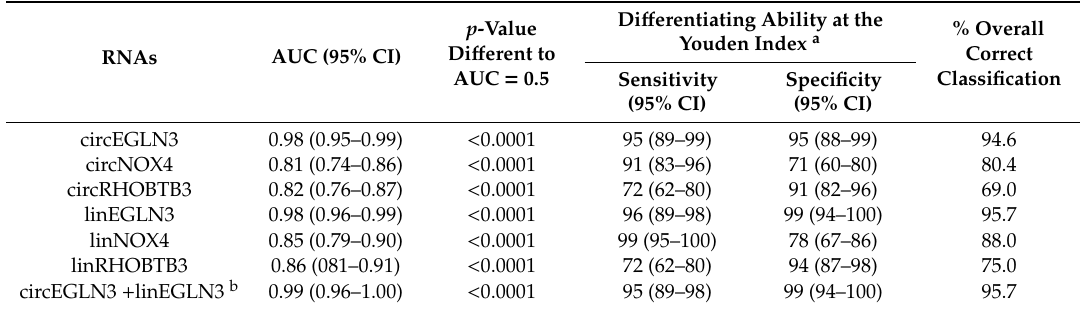
Table 4. Receiver-operating characteristic curve analyses of circRNAs and their linear transcripts to discriminate between adjacent normal and malignant